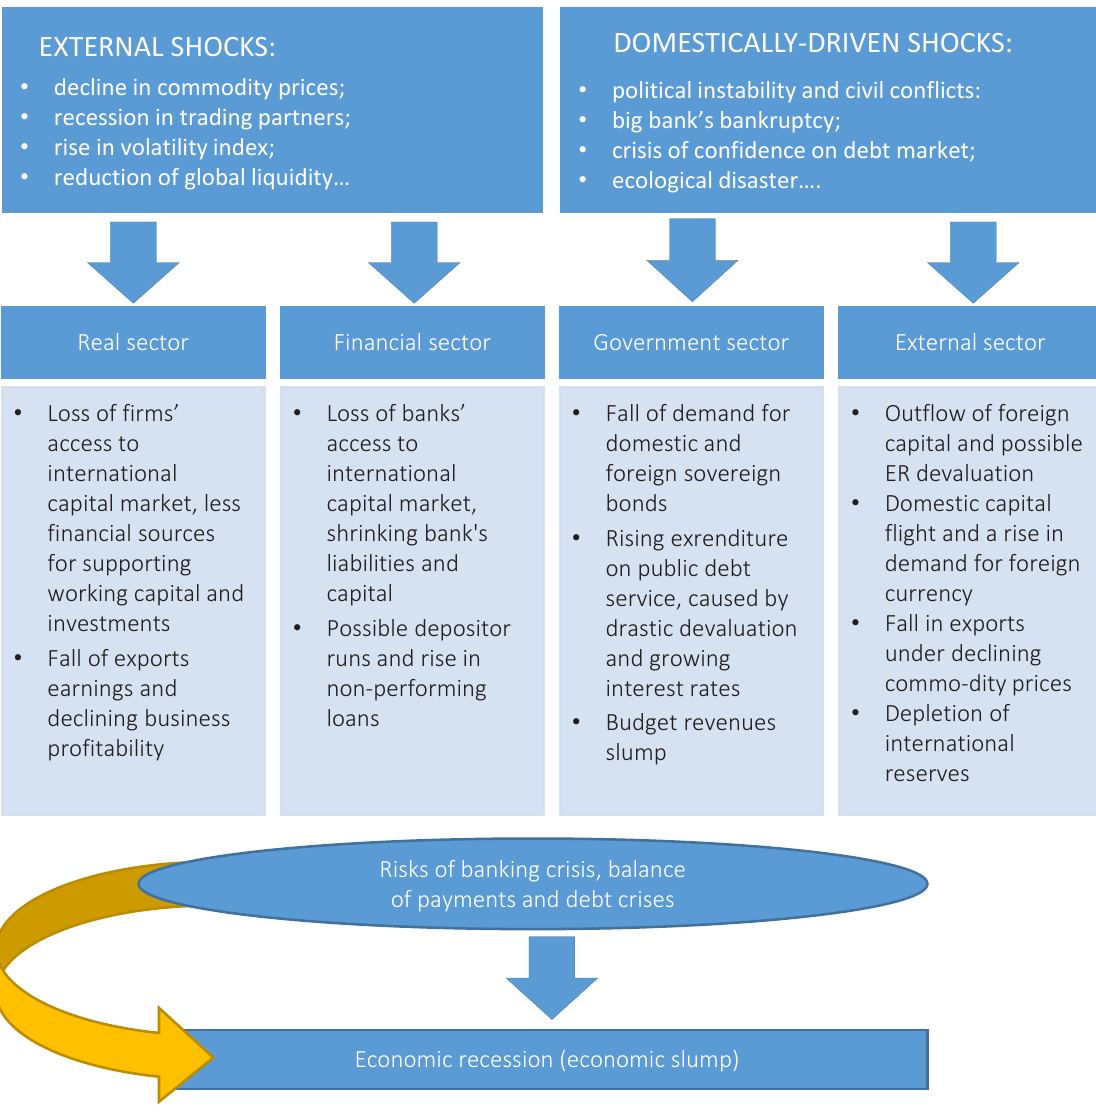
Figure 2. Areas and mechanisms of shocks spillovers in Ukraine’s